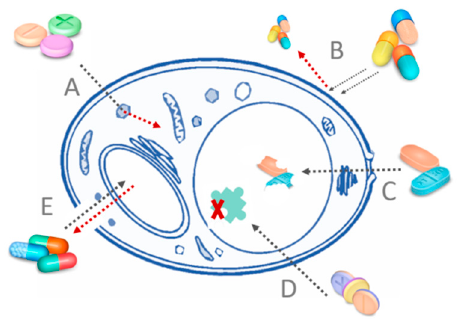
Figure 2. Mechanisms of fungal resistance: ( A ) The development of new mechanisms by fungi, which are no longer a target for antifungals. ( B ) Limiting the penetration of substances from the outside of the matrix. ( C ) Breakdown of antifungals by enzymes. ( D ) Changing the molecular target. ( E ) Pumping out molecules from the inside of the cell.